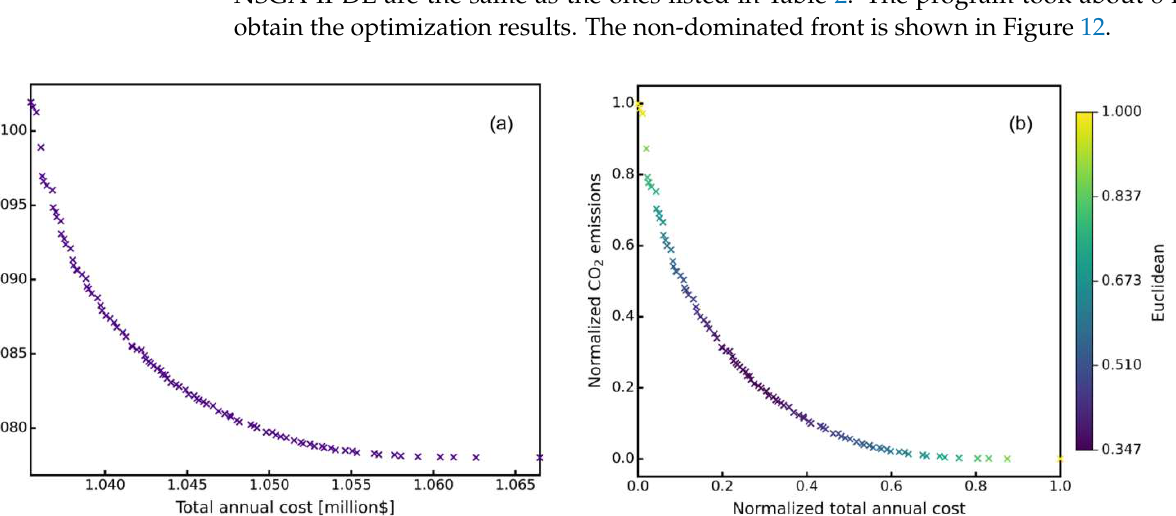
Table 5. Comparison between initial results and NSGA-II-DE optimization